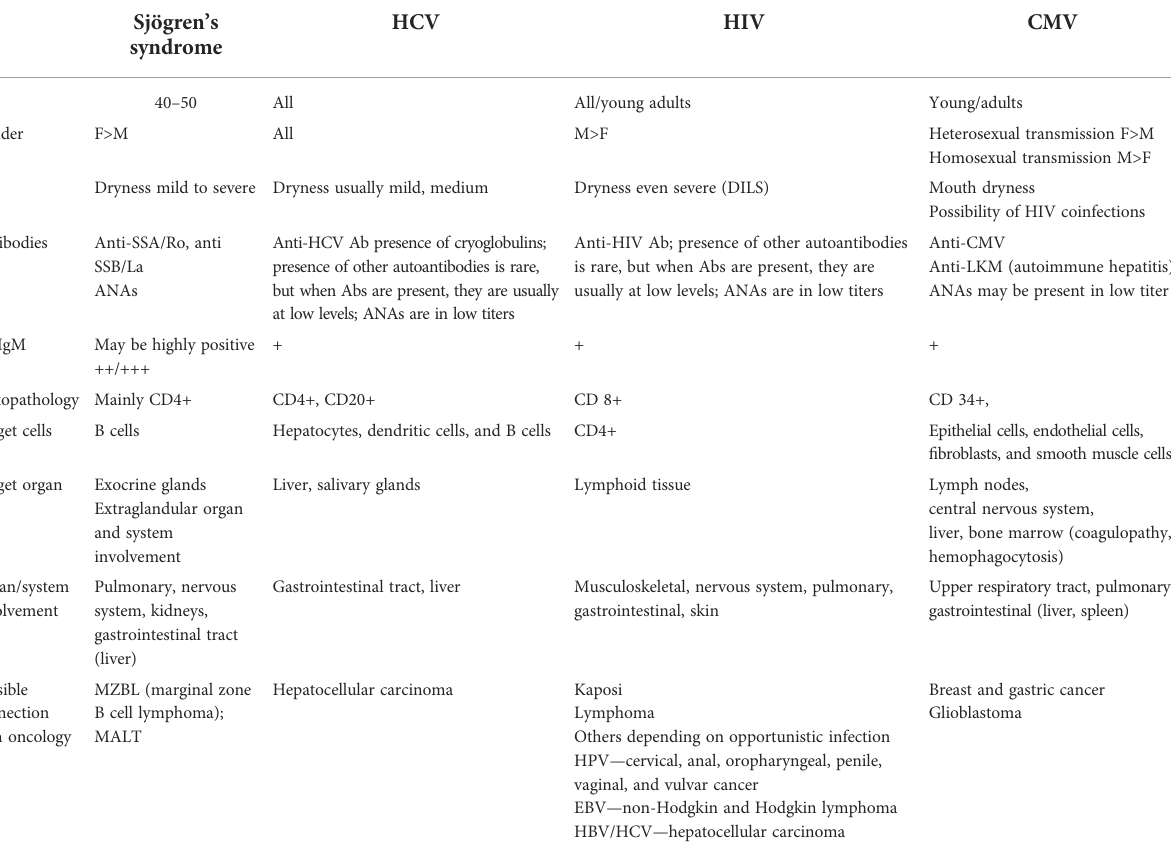
TABLE 4 Differences between pSS, HCV, HIV and CMV (3, 7, 77, 85, 124, 126, 149, 150) .